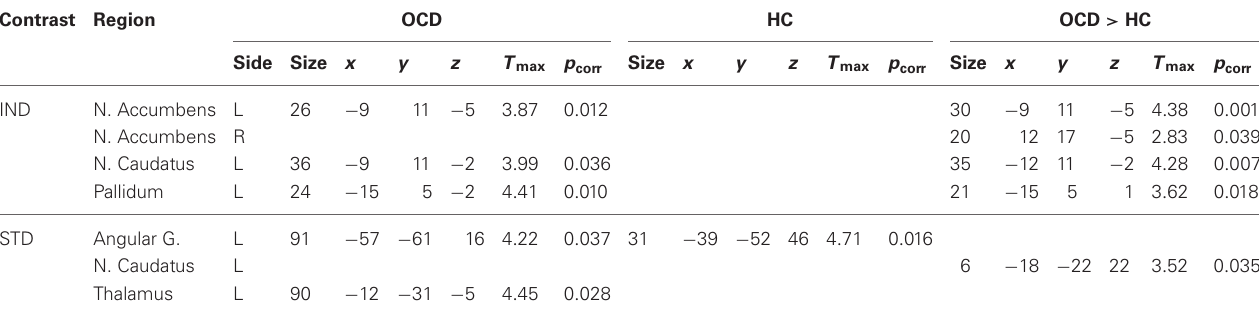
Table 3 | Within-group and between-group results of ROI analyses for both standardized and individualized symptom provocation. Contrast